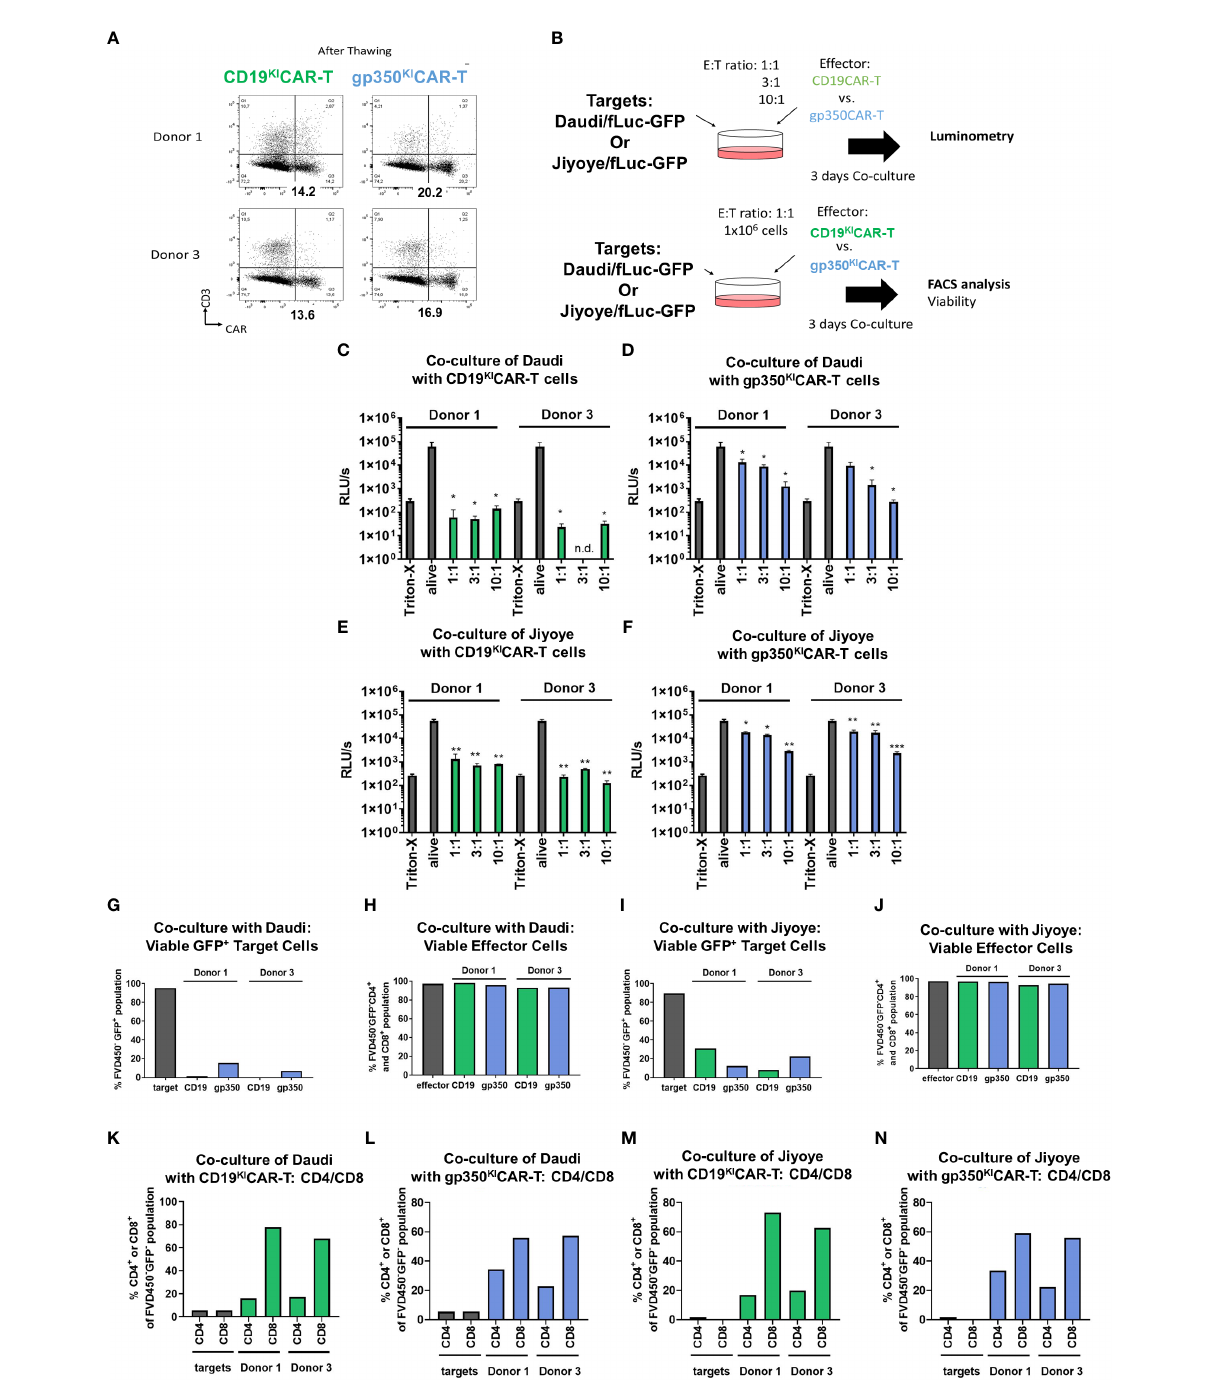
FIGURE 4 CAR KI -T cells produced on a large scale, cryopreserved and thawed, show improved killing of EBV + Burkitt lymphoma cell lines in vitro . (A) Flow cytometry analyses (x-axis: CAR; y-axis: CD3) of CD19 KI CAR-T and gp350 KI CAR-T cells generated with PBMCs of two healthy donors after cryopreservation and thawing. (B) Schematic representation of functional analyses of CD19 KI CAR-T and gp350 KI CAR-T cells after co-culture with Daudi/fLuc-GFP and Jiyoye/fLuc-GFP cell lines at different E:T ratios. After 3 days of co-culture, cell killing was quanti fi ed via luminometry (upper diagram) and fl ow cytometry (lower diagram). (C – F) Luminometry detection (relative light units per second (RLU/s)). Triton-X was used to determine the maximum rate of killing, whereas non-treated alive cells were used as controls. (C, E) CD19 KI CAR-T effectors co-cultured with